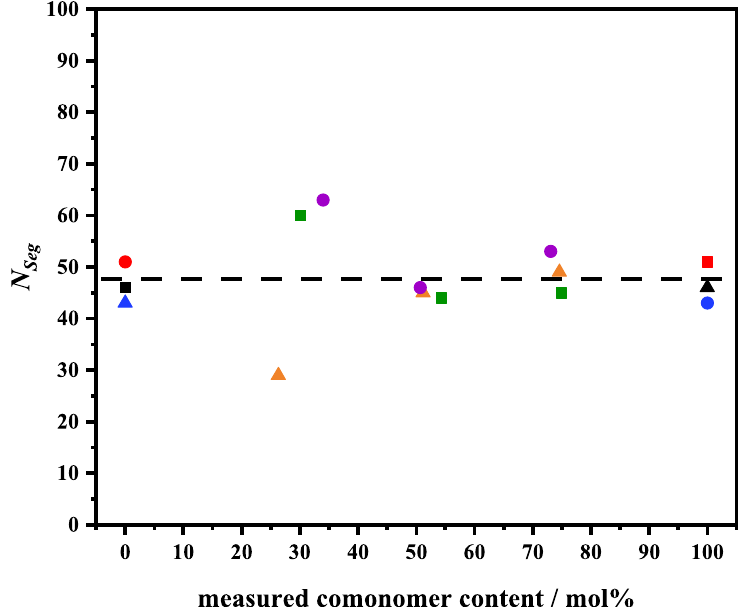
Figure 4. Average degree of polymerization N Seg vs. measured comonomer content poly(NNPAM-co- NIPAM) (squares), poly(NIPAM-co-NIPMAM) (circles) and poly(NIPMAM-co-NNPAM) (triangles). The dashed line marks the mean at